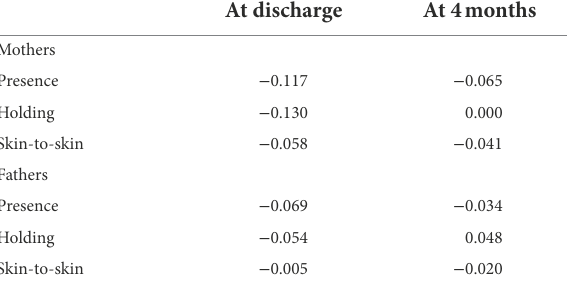
TABLE 4 Pearson correlations coefficients (r) between the types of parent-infant closeness (minutes per day) and square-rooted EPDS scores at discharge and at 4 months of corrected age of the infant for the mother and